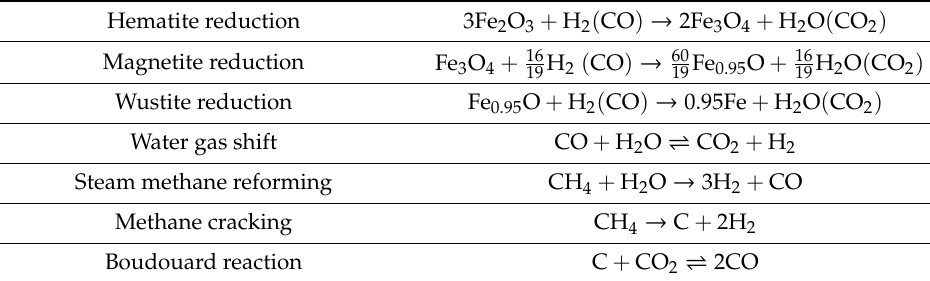
Table 1. Chemical reactions considered inside the shaft